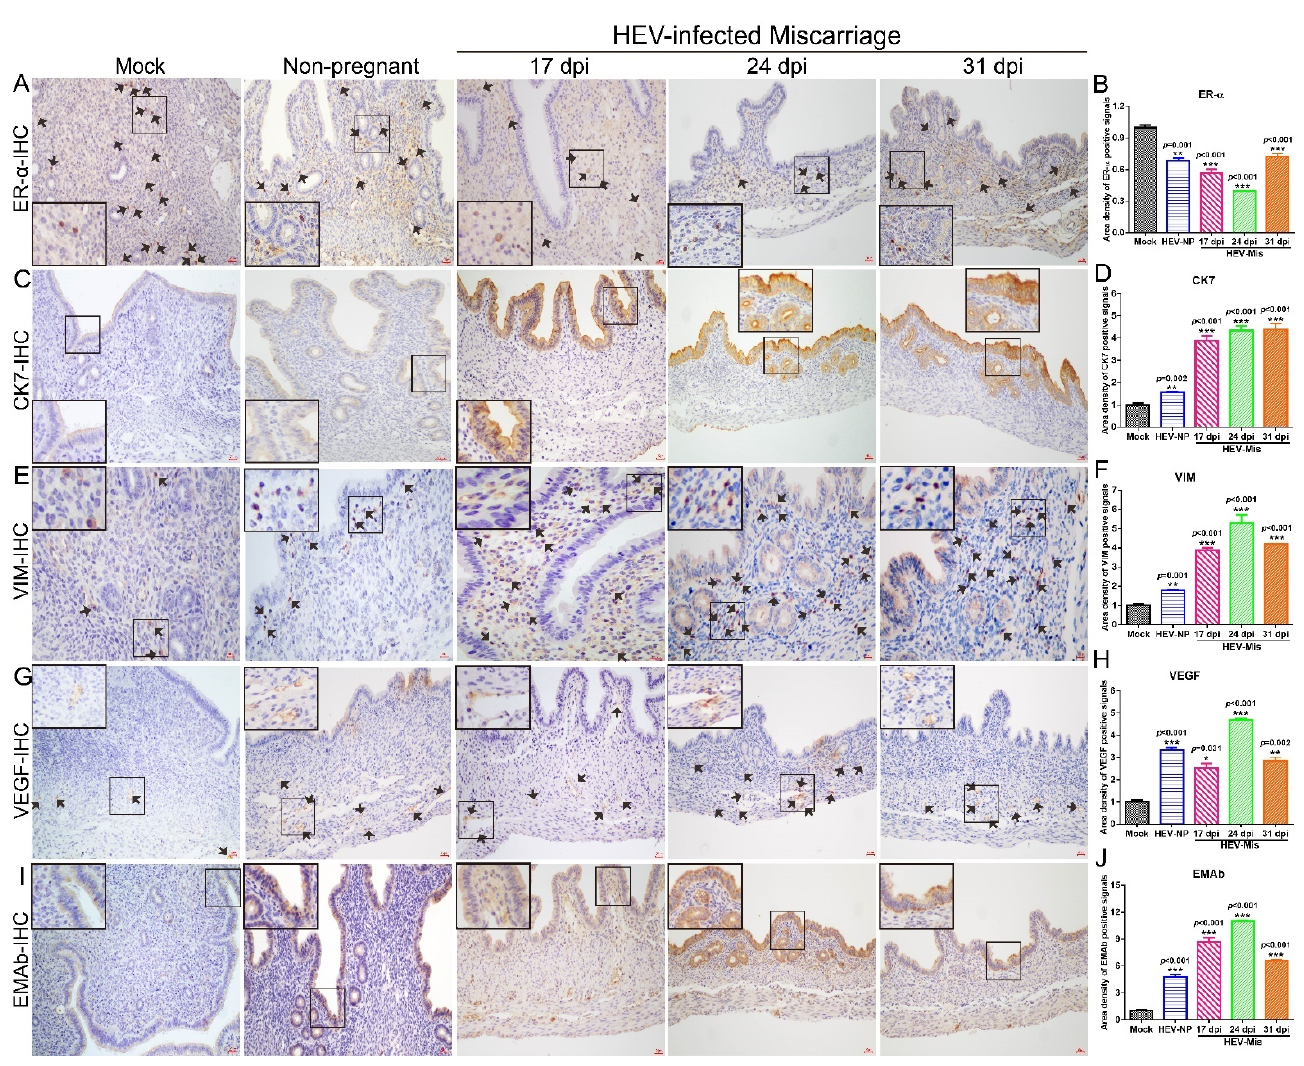
Figure 5. HEV infection causes gene disorders in mice that had miscarried. The expressions of ER ‐α ( A ), CK ‐ 7 ( C ), VIM ( E ), VEGF ( G ), and EMAb ( I ) in the uteruses of mock mice, HEV ‐ infected nonpregnant mice, or HEV ‐ infected mice that had miscarried at 17, 24, or 31 dpi were determined by IHC. Positive signals of ER α ( B ), CK7 ( D ), VIM ( F ), VEGF ( H ), and EMAb ( J ) in the uteruses of mock mice, HEV ‐ infected nonpregnant mice, and HEV ‐ infected miscarriage mice were separately calculated by Image-Pro Plus 6.0 software and compared by IBM SPSS Statistics 21 software. * p < 0.05; ** p < 0.01; *** p < 0.001.